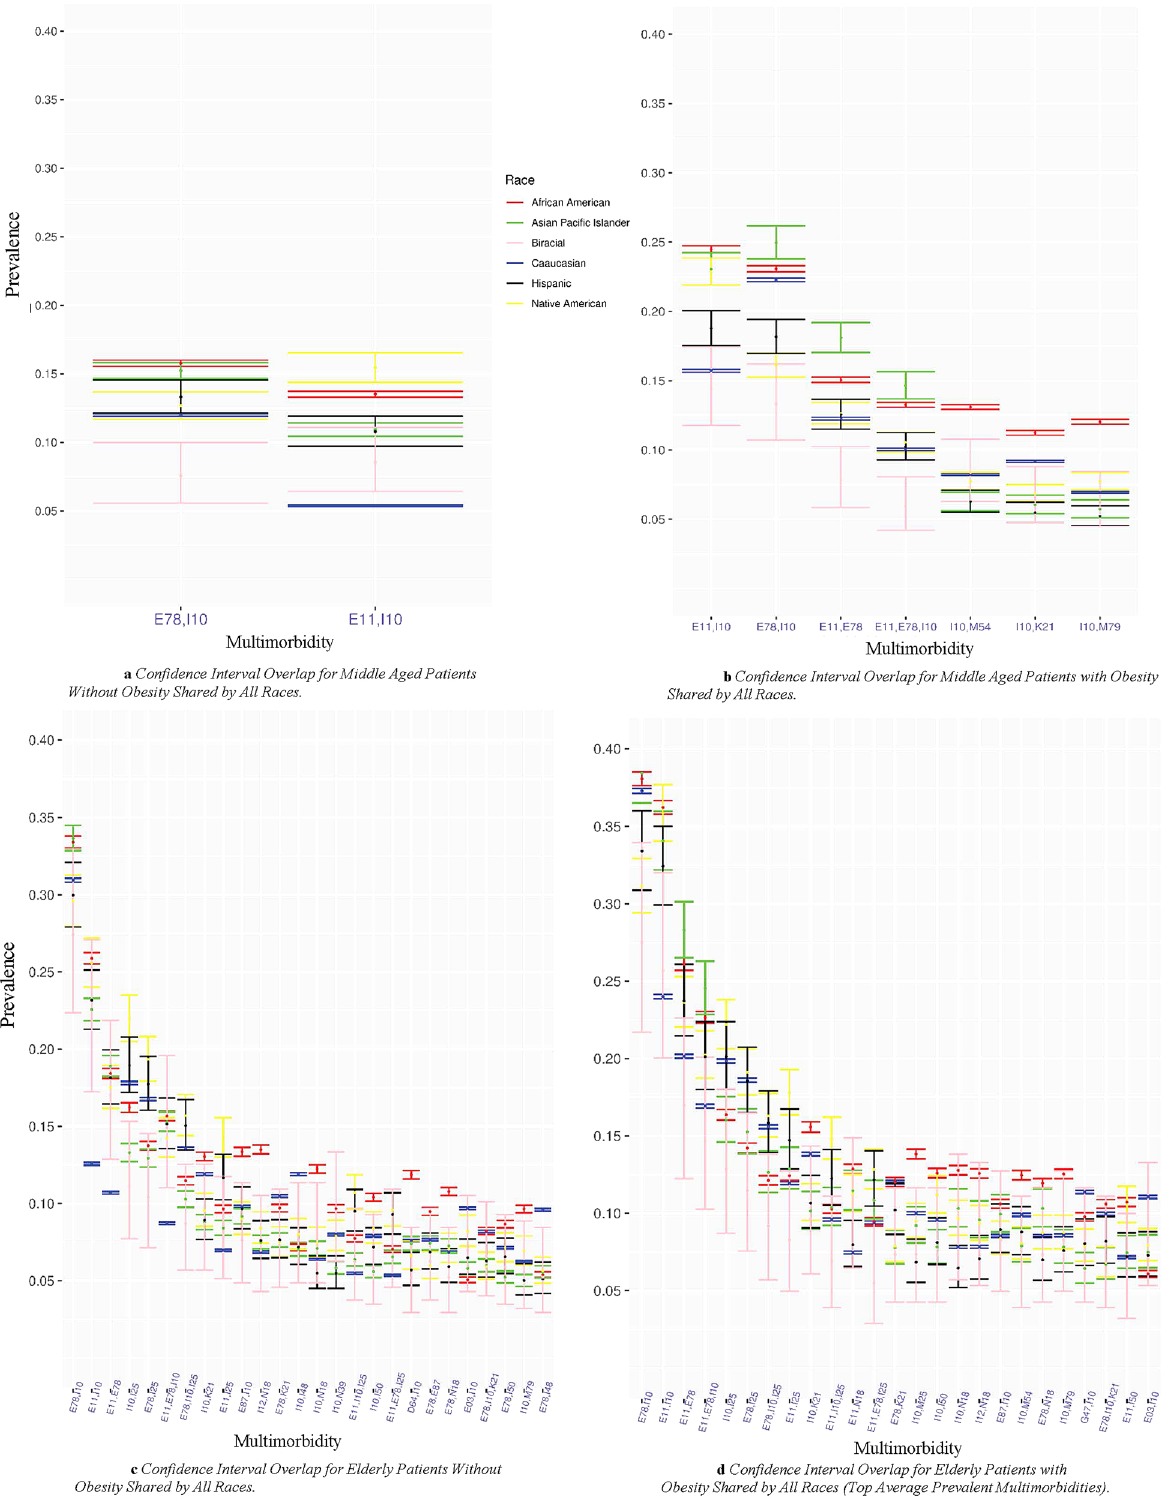
Figure 1. ( a , b ) Demonstrate the 95% confidence interval overlap for shared multimorbidities among middle aged patients without obesity and patients with obesity, respectively, at 5% prevalence threshold. The g-test of independence was calculated resulting in all significant results with p < 0.05. ( c , d ) Demonstrate the 95% confidence interval overlap for shared multimorbidities among elderly patients without obesity and patients with obesity, respectively, at 5% prevalence threshold. The chi square test was calculated resulting in all significant results with p < .05 except for the multimorbidity patterns circled in red. Disease Clinical Categories; E: Endocrine, nutritional and metabolic, F: Mental, behavior and neurodevelopmental, G: Nervous System, I: Circulatory system, J: Respiratory system, K: Digestive system, N: Genitourinary system, M: musculoskeletal system and connective tissue. ( d ) Demonstrates shared multimorbidities with average prevalence ≥